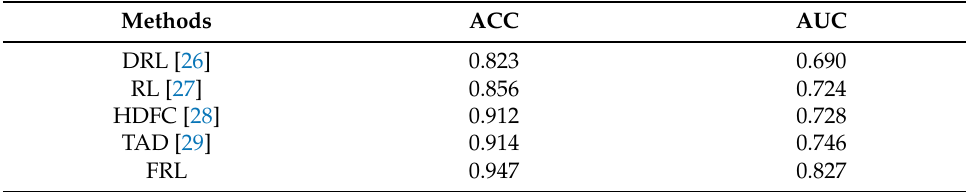
Table 2. Comparison of experimental